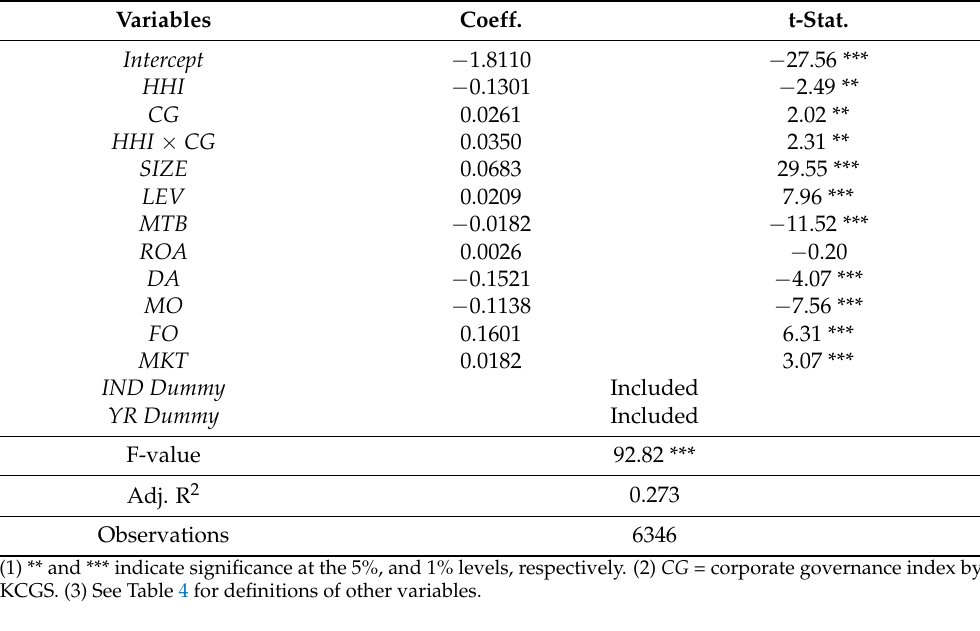
Table 5. The regression result of Hypothesis